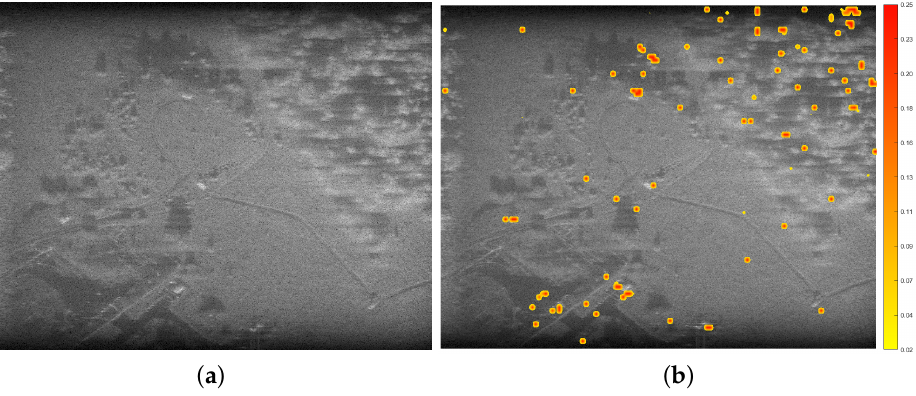
Figure 10. ( a ) SAR image of scene 2. ( b ) Uncertainty heat map superimposed onto scene 2. A group of high uncertainty detections are observed over the forest